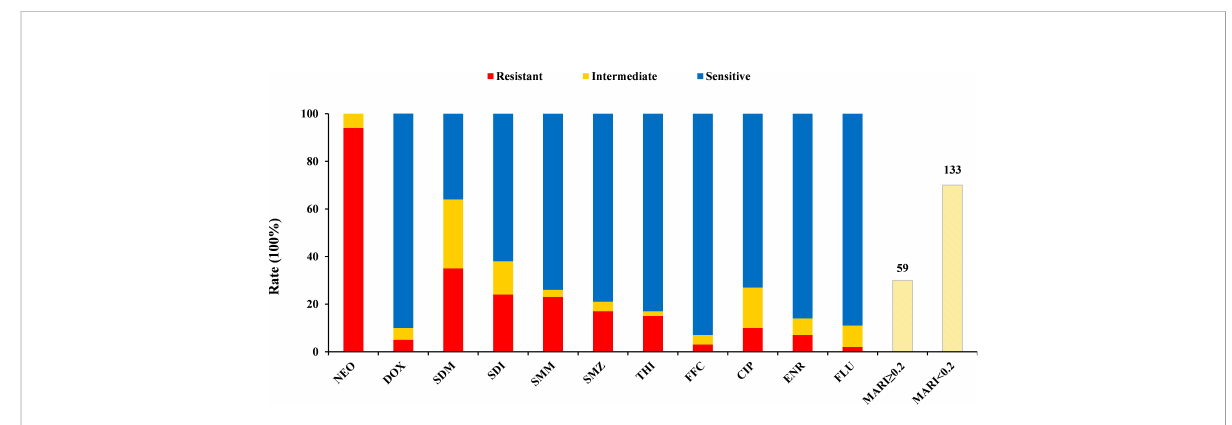
FIGURE 6 Antibiotic resistance pro fi les of the Harveyi clade isolates. The colors represent different levels of resistance. : resistance, : intermediate, : susceptibility. Note: MAR index is calculated by dividing the total numbers of the tested antibiotics into the numbers of antibiotics, to which the isolate was